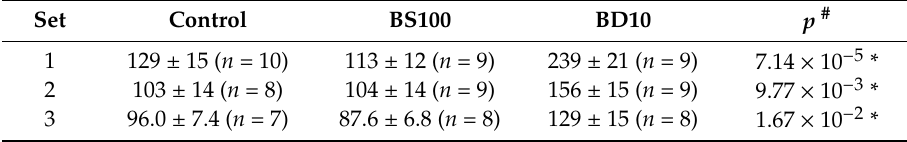
Table 6. Mean number of apoptotic events ( ± SEM) obtained in the control, BS100 and BD10 groups from 3 sets of experiments. n : numbers of embryos involved in the analyses. # p values obtained by comparing the BS100 and BD10 groups using one-tailed t -test (cases with p < 0.05 are